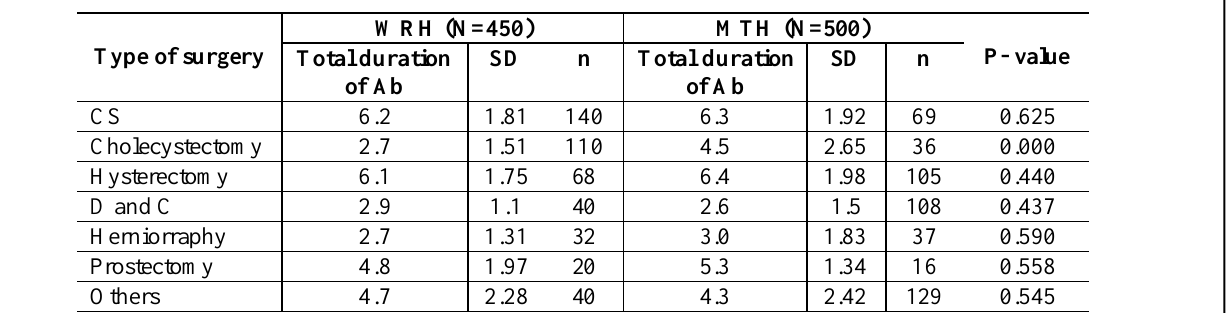
Table IV : Total antibiotic duration in different